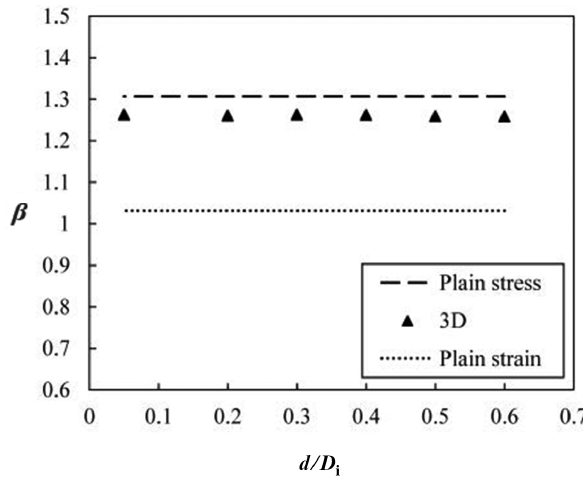
Figure 9: The effects of d / D i ratio on β values for specimens with L